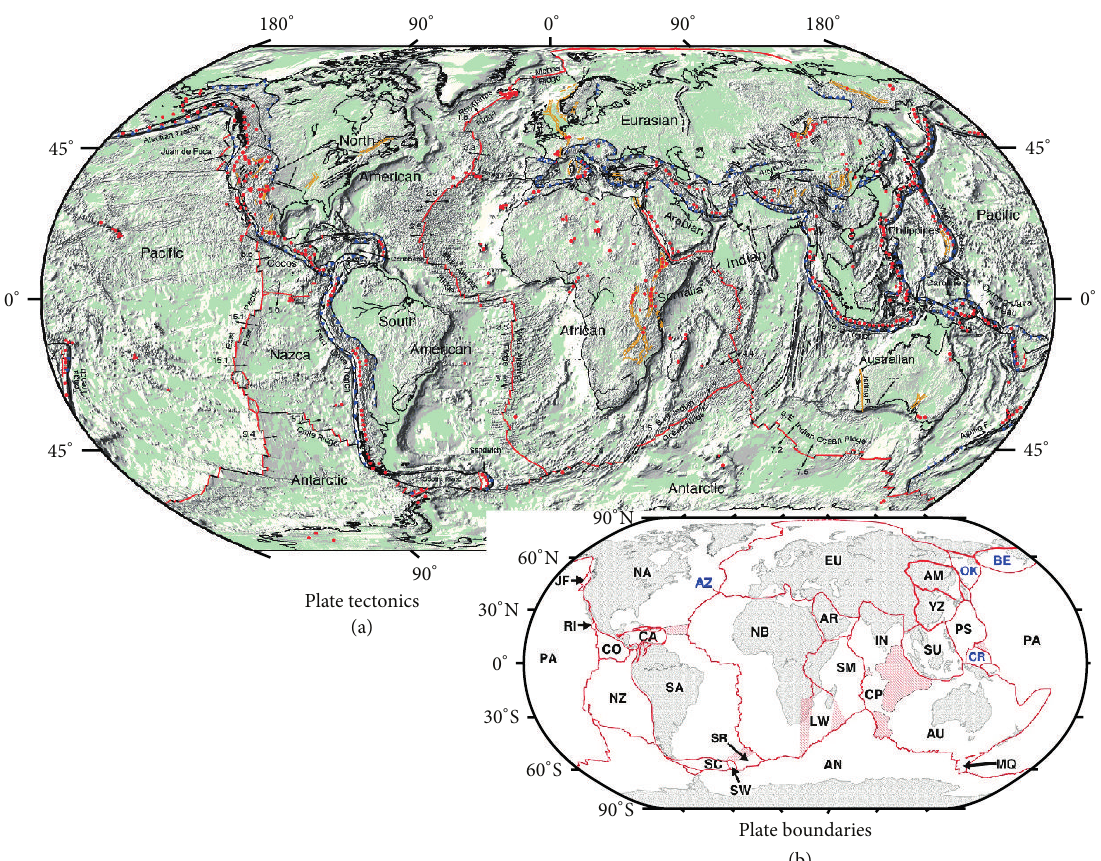
Figure2:TheEarth’slithosphereisdividedintoseveraltectonicplatesthatundergorelativemotion.Plateboundariesaredivergentboundaries (seafloor spreading ridges), convergent boundaries (subduction zones), and transform boundaries (transform faults). (a) Plate tectonic boundaries. Structural information on normal and reverse faults and volcanic centers is added (credits: NASA Earth Observatory and Goddard Space Flight Center website: http://earthobservatory.nasa.gov). (b) Global plate model incorporating 27 plates in a high resolution plate kinematic model (adapted from DeMets et al.